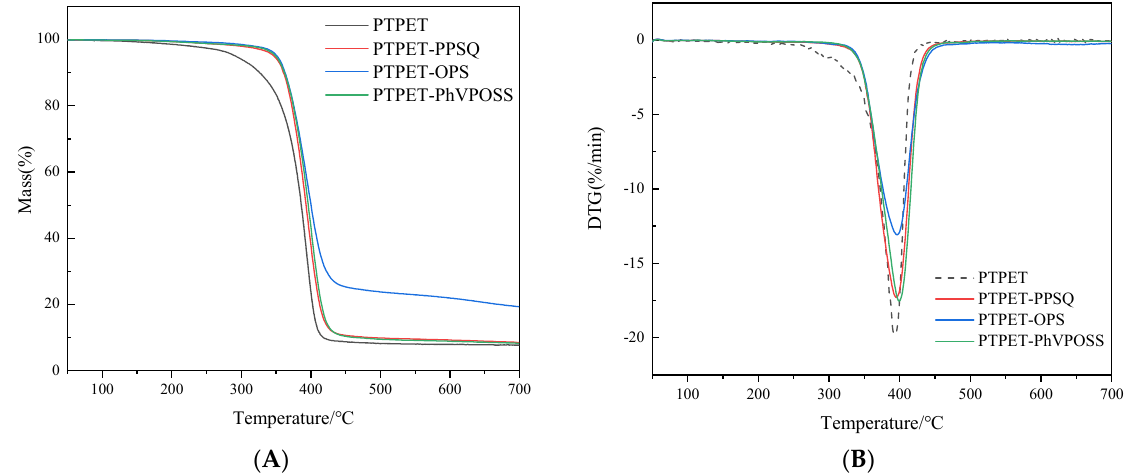
Figure 9. FT-IR analysis of PTPET-PhVPOSS.